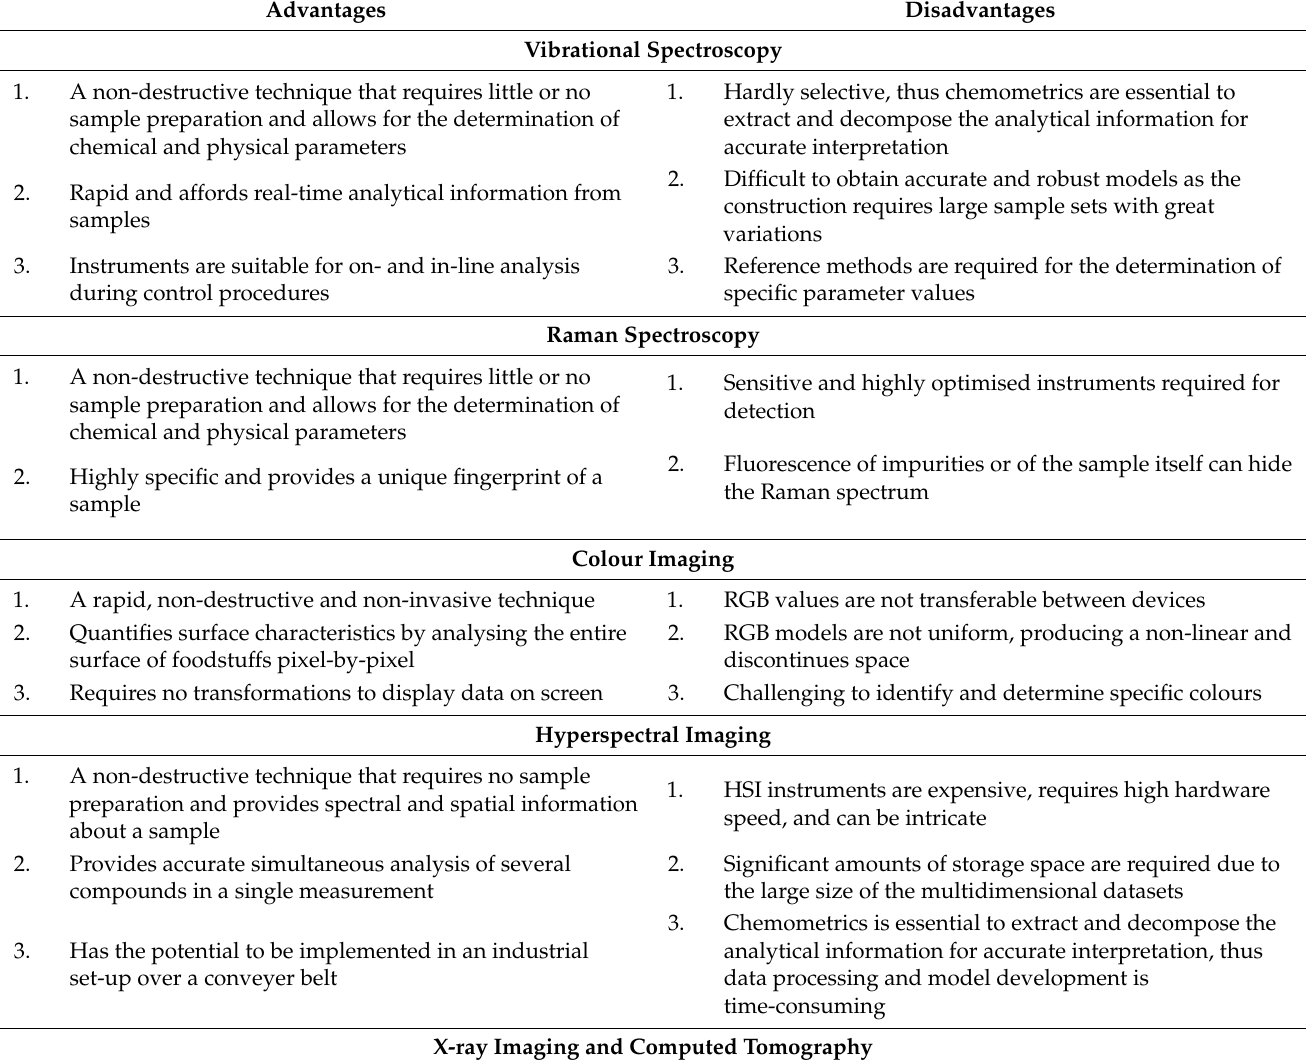
Table 1. The advantages and disadvantages of selected non-destructive spectroscopic and imaging methods evaluated for the authentication of processed meat